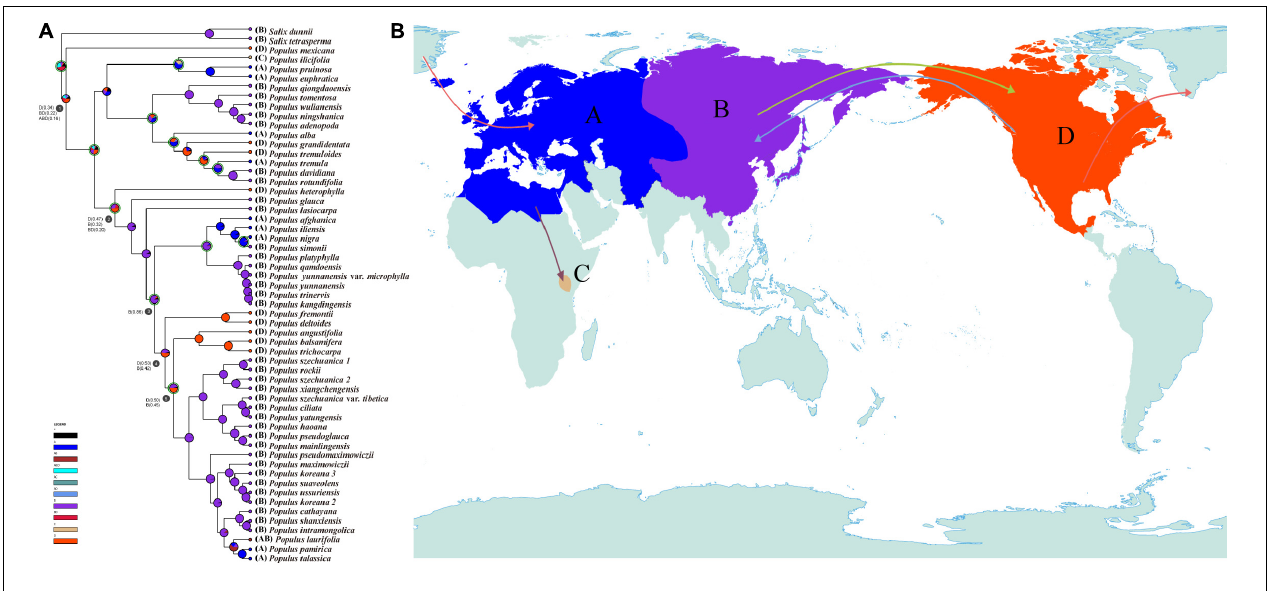
FIGURE 5 | Ancestral areas of the genus Populus . (A) Ancestral area reconstructions of genus Populus using DEC + J model, implemented in RASP. Possible ancestral ranges and their respective probabilities are shown at each node. The four areas of endemism considered are as follows: (A) Europe, North Africa, West-Central Asia, and Xinjiang, China; (B) North Asia, East Asia, and the edge of Himalayas; (C) Kenya; and (D) North America. (B) Possible migration routes of the genus Populus . Solid arrows indicate inferred migration routes for the genus Populus